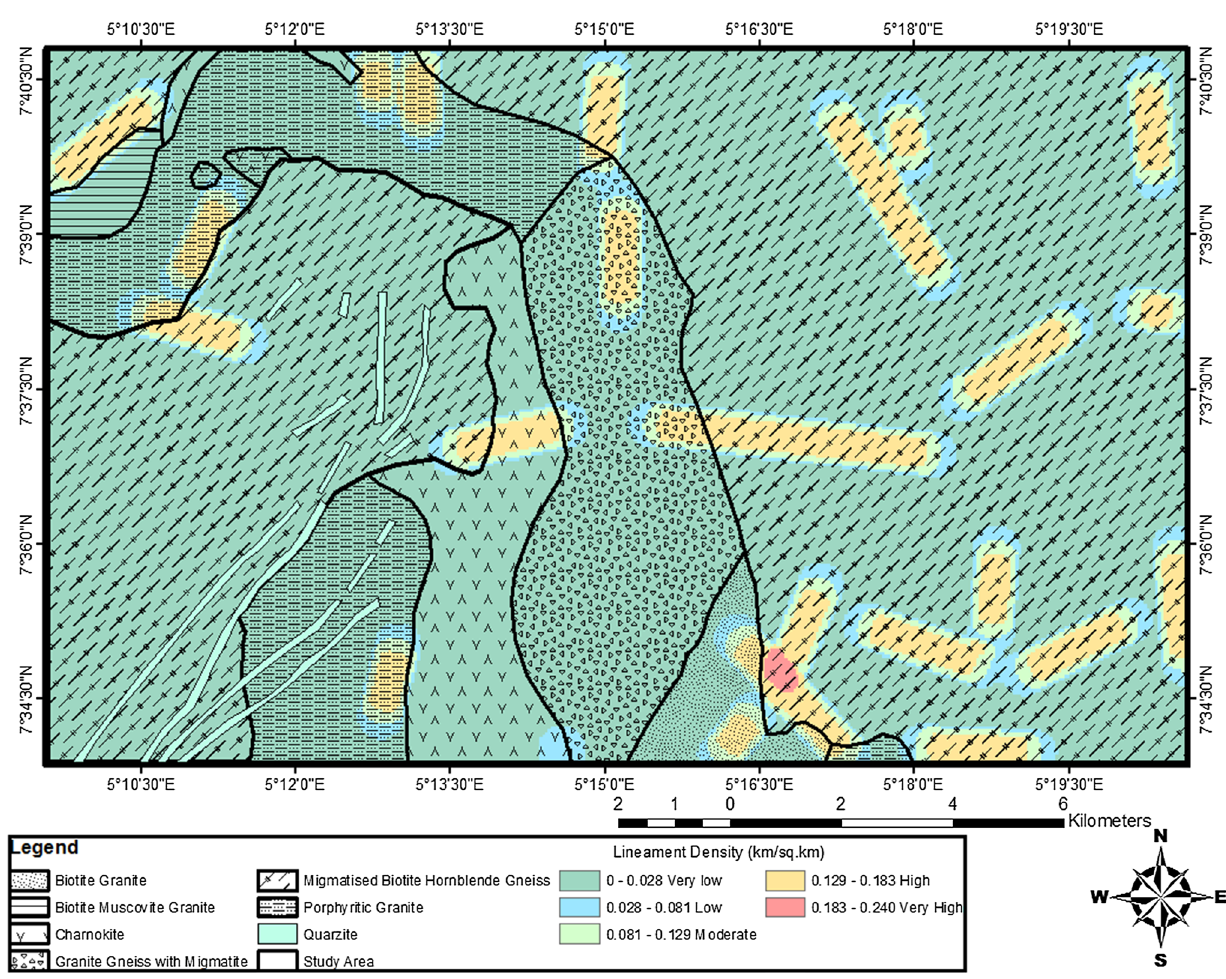
Fig. 6 Lineament density map of the study